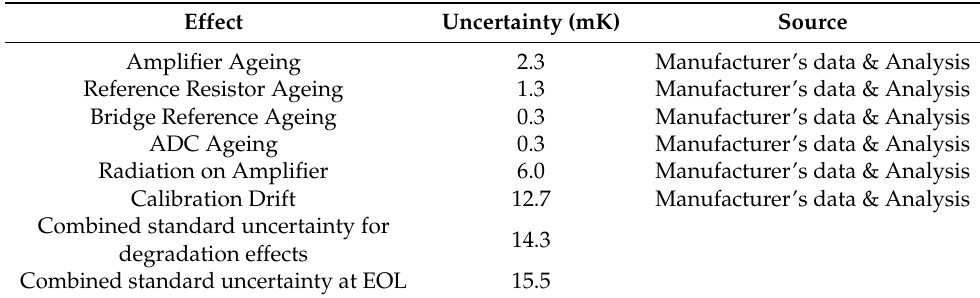
Table 5. SLSTR temperature measurement uncertainties due to degradation effects over 7.5 year